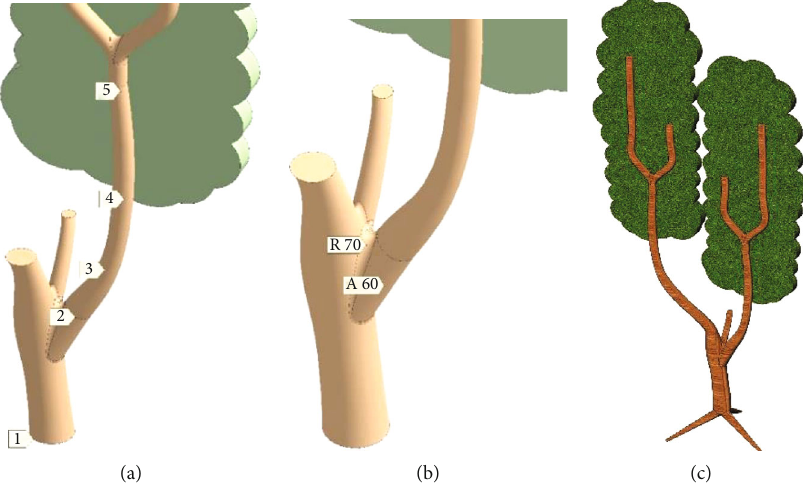
Figure 4: Models of the branch: (a) the trunk-branch junction; (b) the tree with two branches; (c) two crowns and stylized roots